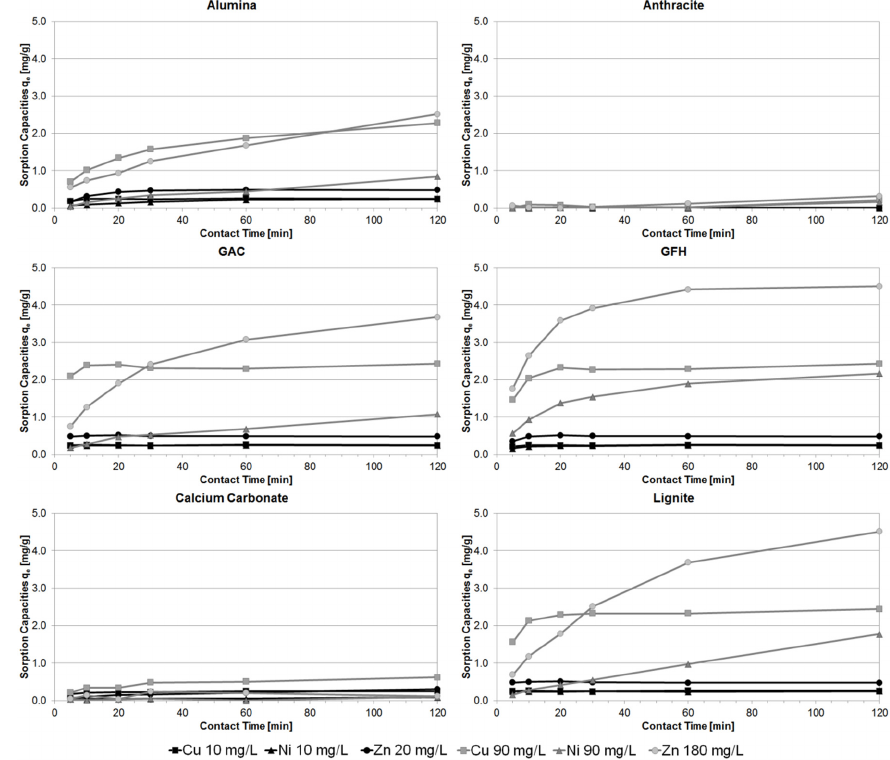
Figure 4. Results of the kinetic experiments with two initial concentrations (rotary shaker, pH 5, and no buffer).